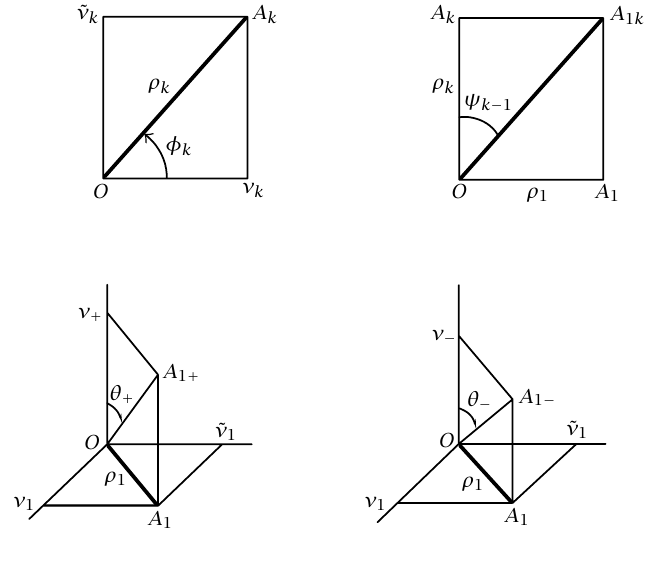
Figure 2.2 . Angular variables for the description of n -complex